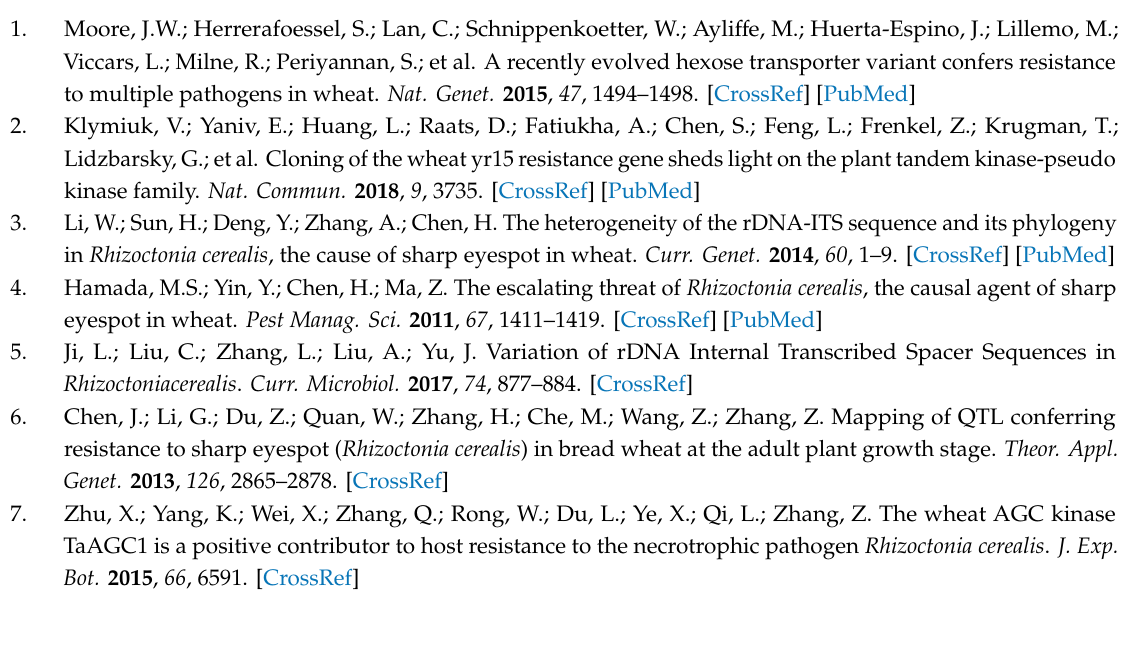
Figure S1: Sequence alignment among RcXYN proteins in Rhizoctonia cerealis andstructures of their coding genes. (A) Sequence alignment among nine Rhizoctonia cerealis xylanases proteins. (B) Exons and introns are indicated by black boxes and lines, respectively. The 5 (cid:48) -3 (cid:48) scale indicates the DNA sequence size. The names of the RcXYN genes and intron-exon structures are indicated at the left and right sides, respectively. Table S1: All primers